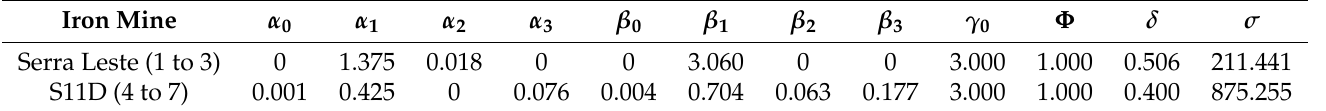
Table 5. Calibrated parameters in Scenario 1